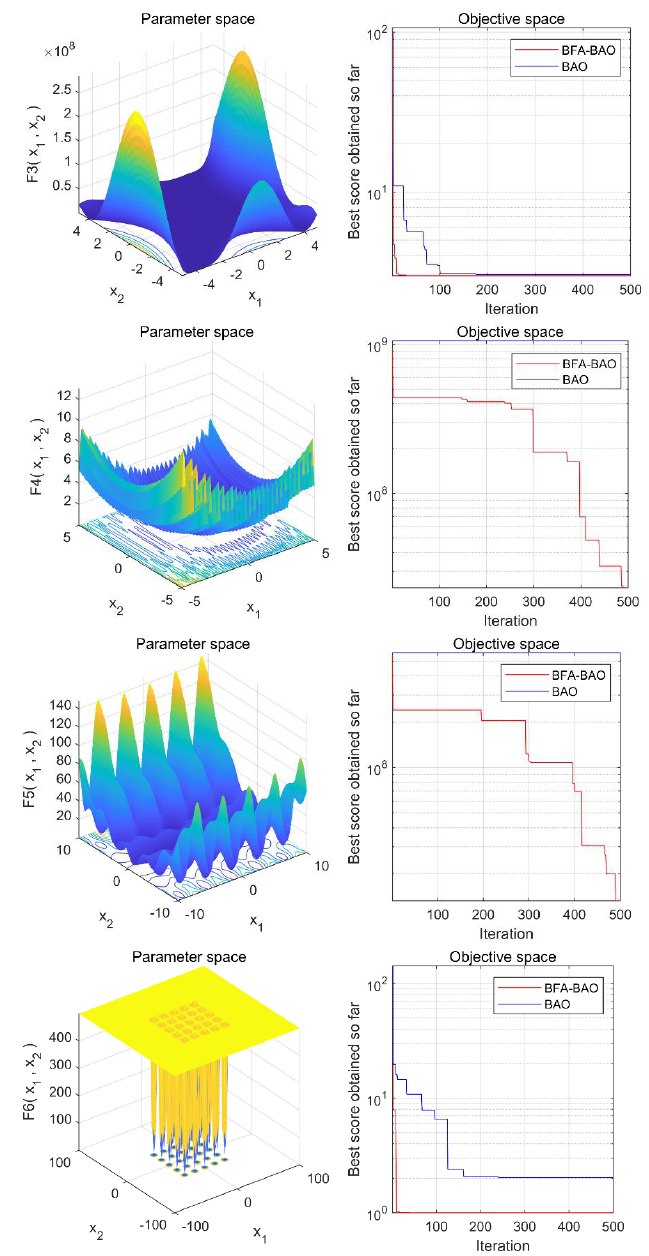
Figure 1. Simulation results of performance test functions on BAO and BFA-BAO algorithms.